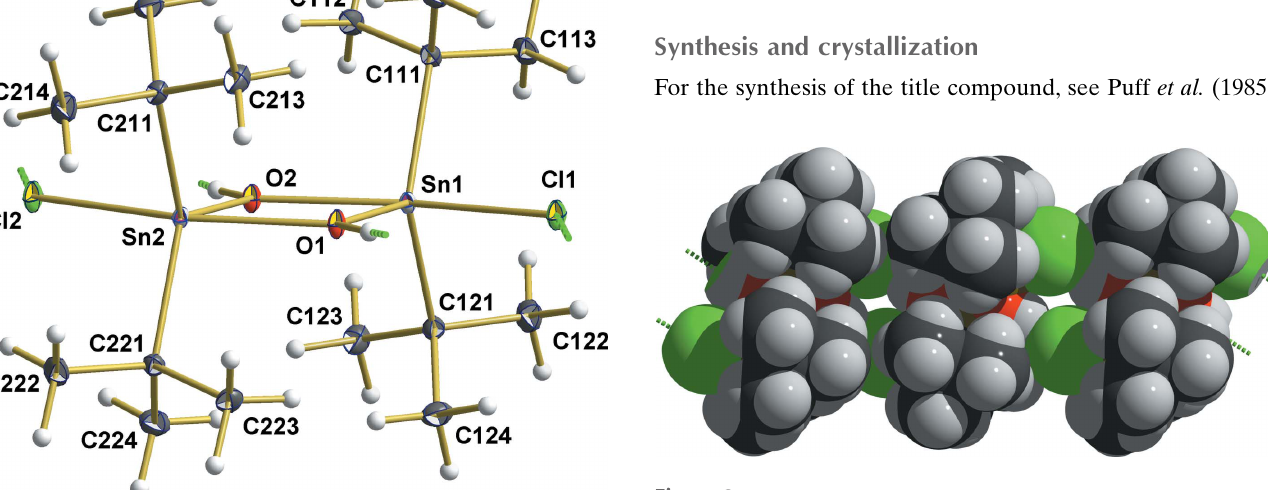
Figure 3 Space-filling model of the chain-like arrangement of the [ t Bu 2 Sn- (OH)Cl)] 2 molecules along [101] encompassing intramolecular O— H (cid:2)(cid:2)(cid:2) Cl hydrogen bonding. The image shows three complete molecules with their hydrogen bonds to neighbouring molecules. The corresponding atoms are visualized as truncated, two-coloured spheres and the hydrogen bonds are indicated by dashed sticks in green. Colour code of the atoms: Cl = green, H = white, C = grey, O = red, Sn = brass.